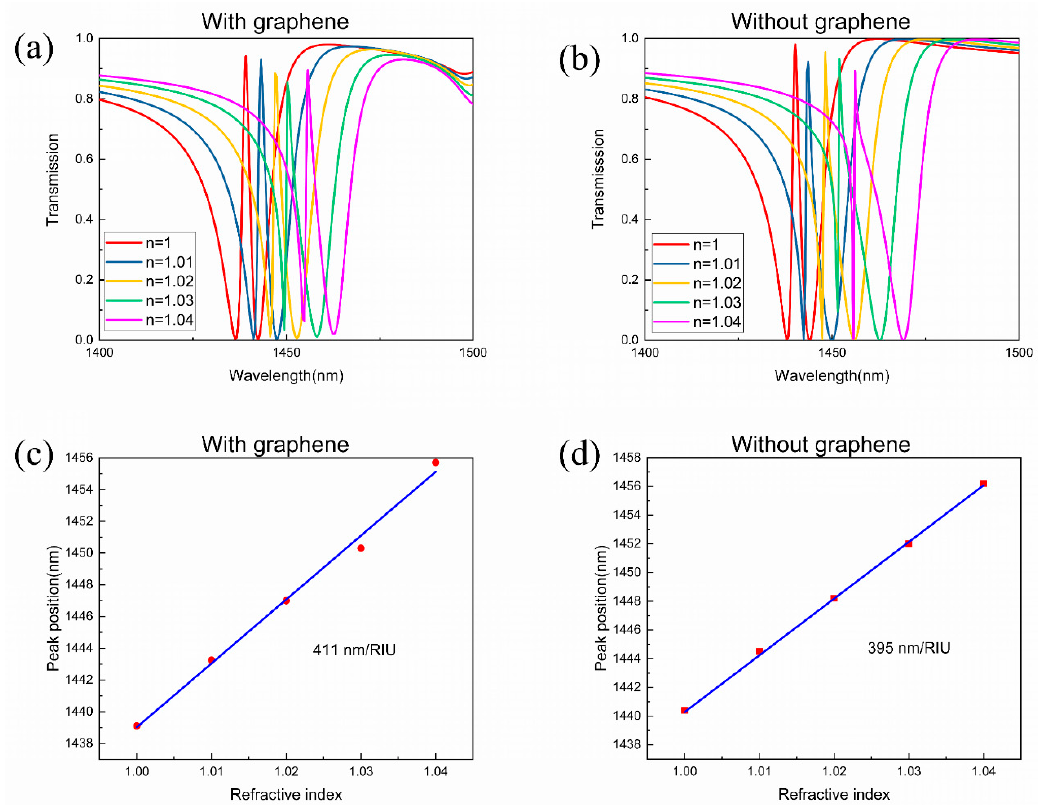
Figure 9. The sensing performance of refractive index. ( a , b ) Simulated transmission spectra of the metamaterial with and without graphene when the environmental refractive index changing from 1 to 1.04. ( c , d ) The red point is the simulated relationship between the peak position and the background refractive index. The blue curve is a liner fit to the simulated data.